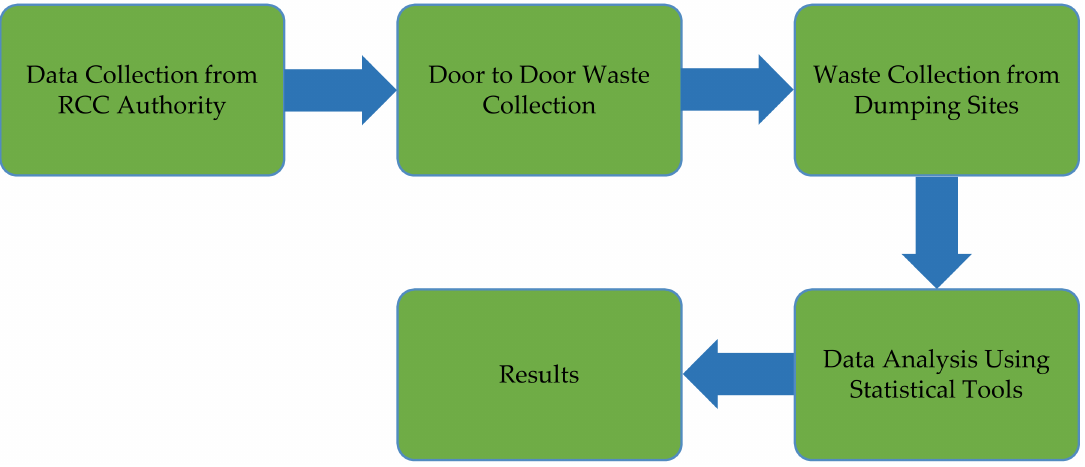
Figure 5. Flowchart of research